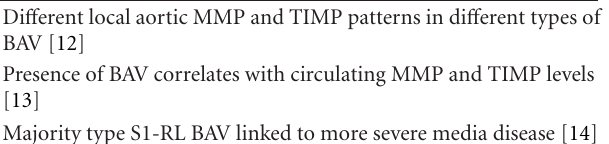
Table 1: Cusp fusion pattern—local hemodynamics—qualitative severity of aortic media